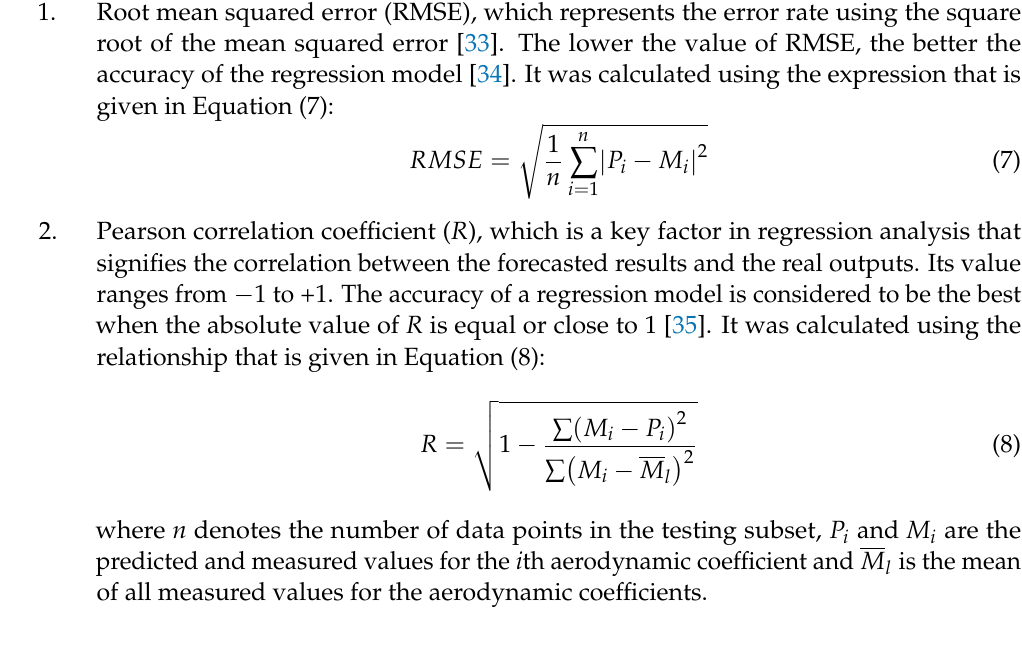
Figure 4. Architecture of the BPNN model for the best performance case.